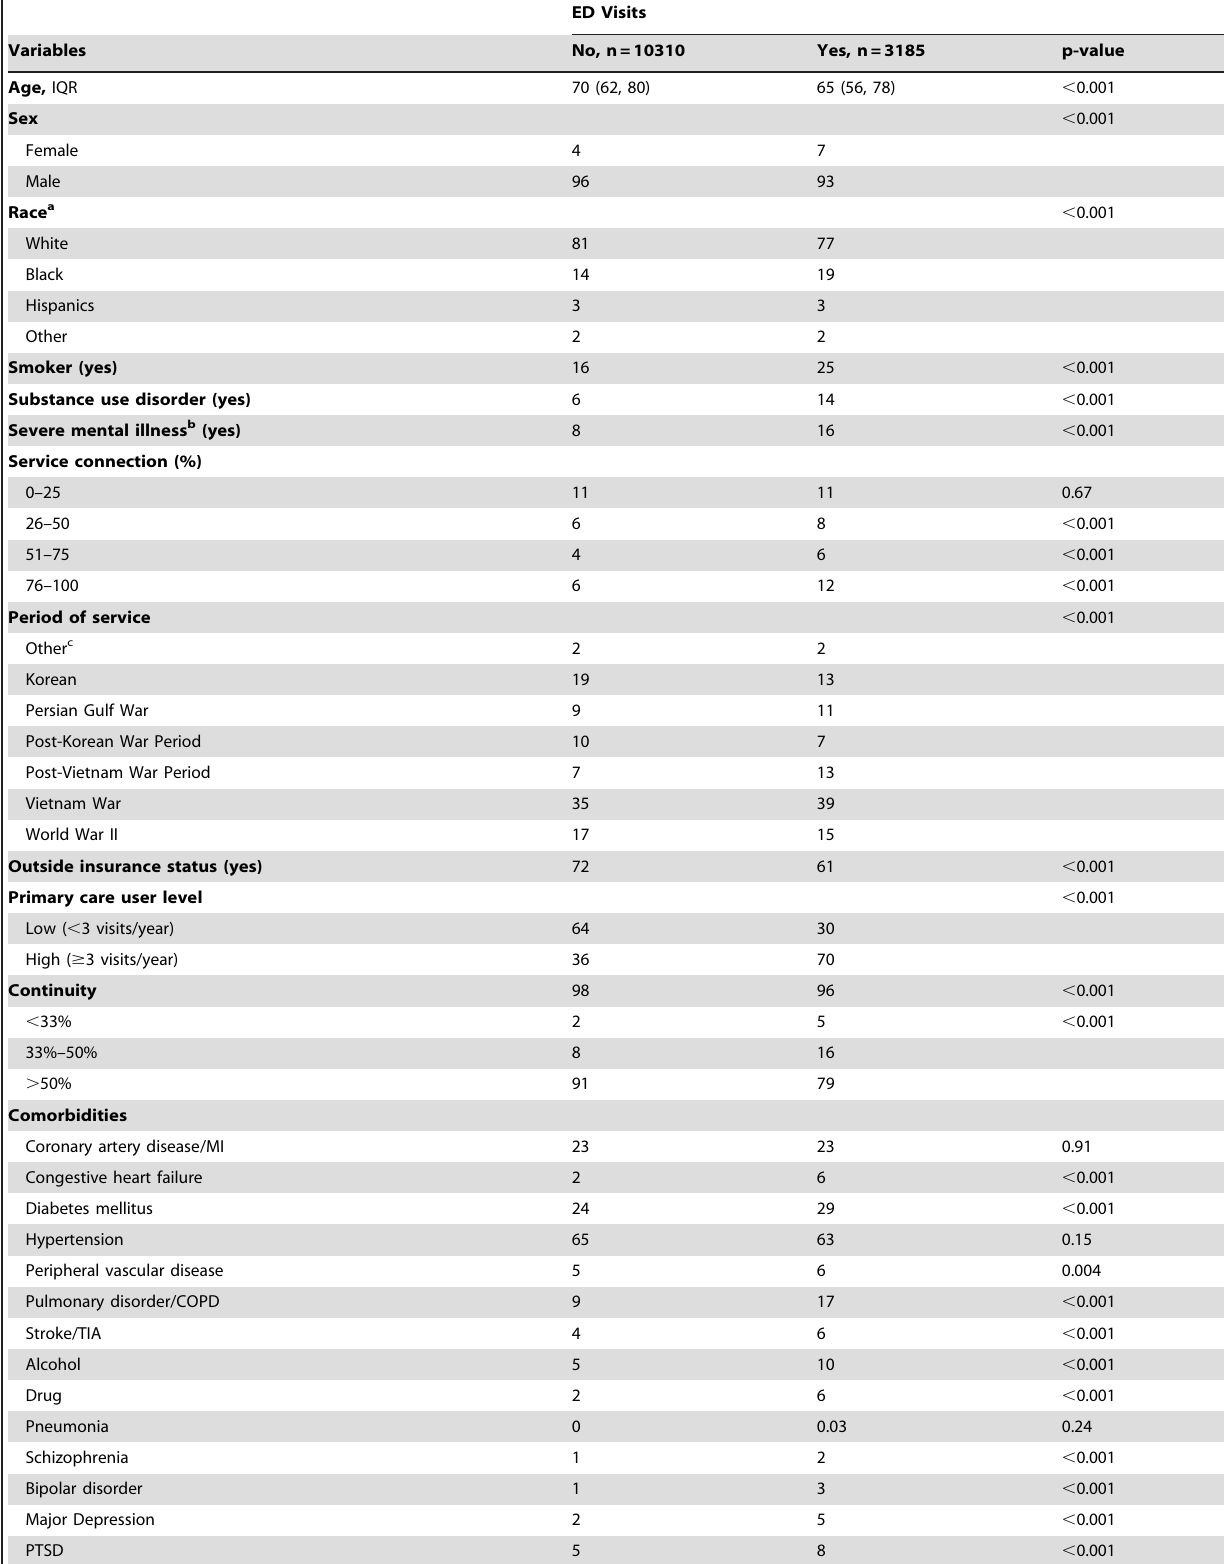
Table 2. Patient Demographics by Emergency Department